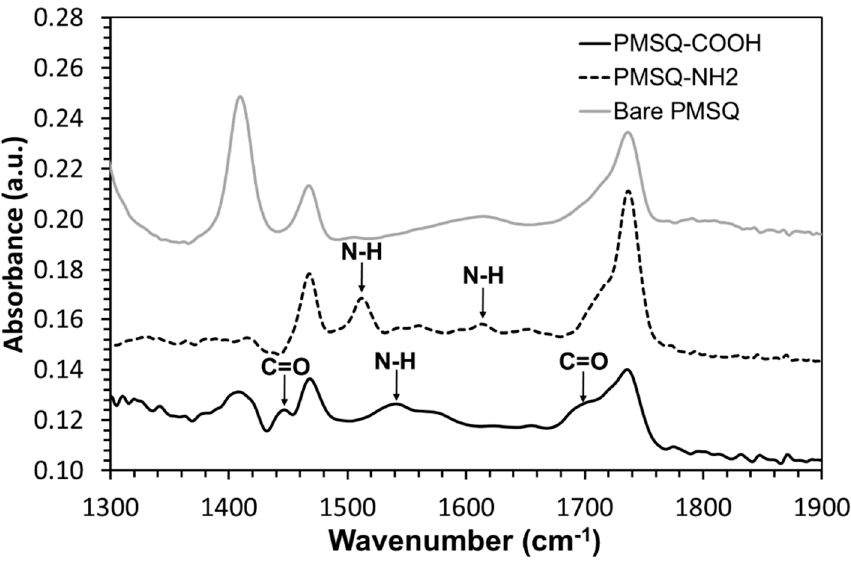
Figure 6. ATR-FTIR spectra of PMSQ-NH 2 Janus particles (black dashed curve), PMSQ-COOH amphiphilic Janus particles (black curve), and bare PMSQ particles (gray curve).